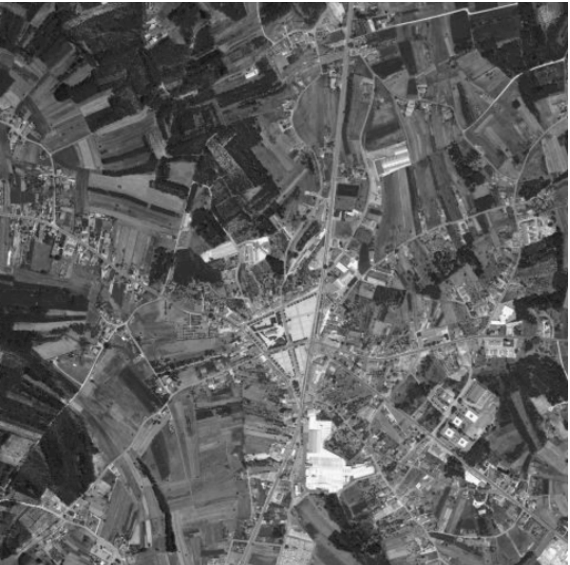
Figure 1. Panchromatic grayscale image. Grayscale version of Figure